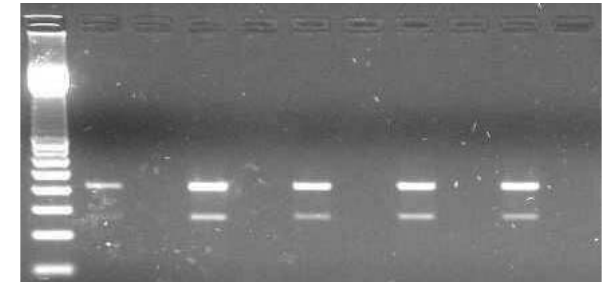
Figure5 -ThecontrolofDNAcontaminationusingtotalRNA.Firstlane- 100 bp ladder of molecular weight markers. Lanes 1, 3, 5, 7, and 9 are amplicons of GH cDNA (418 bp) and the β -actin cDNA (264 bp) obtained using untreated total RNA with RNase-free DNase I as template. Lanes 2, 4, 6, 8, and 10 are equal reactions with untreated total RNA without re- verse transcription. The samples were run on 2% agarose